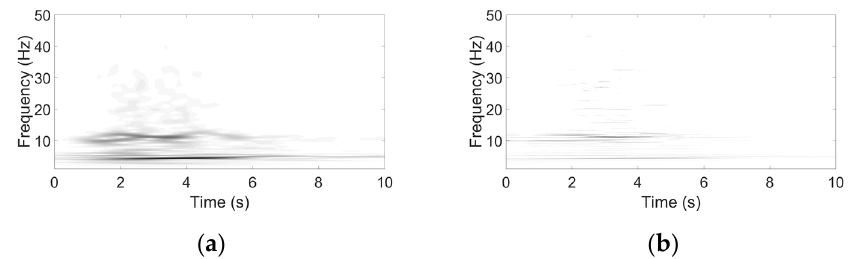
Figure 15. Time–frequency representation of damping force variation: ( a ) wavelet transform; ( b ) SSAWT.